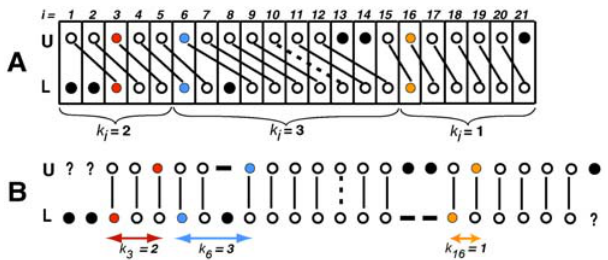
Figure 3. Two renderings of the same alignment, illustrating the concept of phase shift. Circles represent bases and links represent positional homologies: solid links–matches, and dashed links– mismatches. Black closed circles represent bases that have no positional homologs. In (A) vertical columns represent successive configurations of an aligned solution. The pairs of bases at sites 3, 6, and 16 are colored. Curly brackets mark segments aligned with different phase shifts. In (B) vertical columns contain pairs of positional homologs, and gaps are inserted opposite to bases having no homologs; external gaps are shown as question marks. The horizontal distances between the bases of each colored configuration (arrows) represent the correspond- ing phase shifts k i